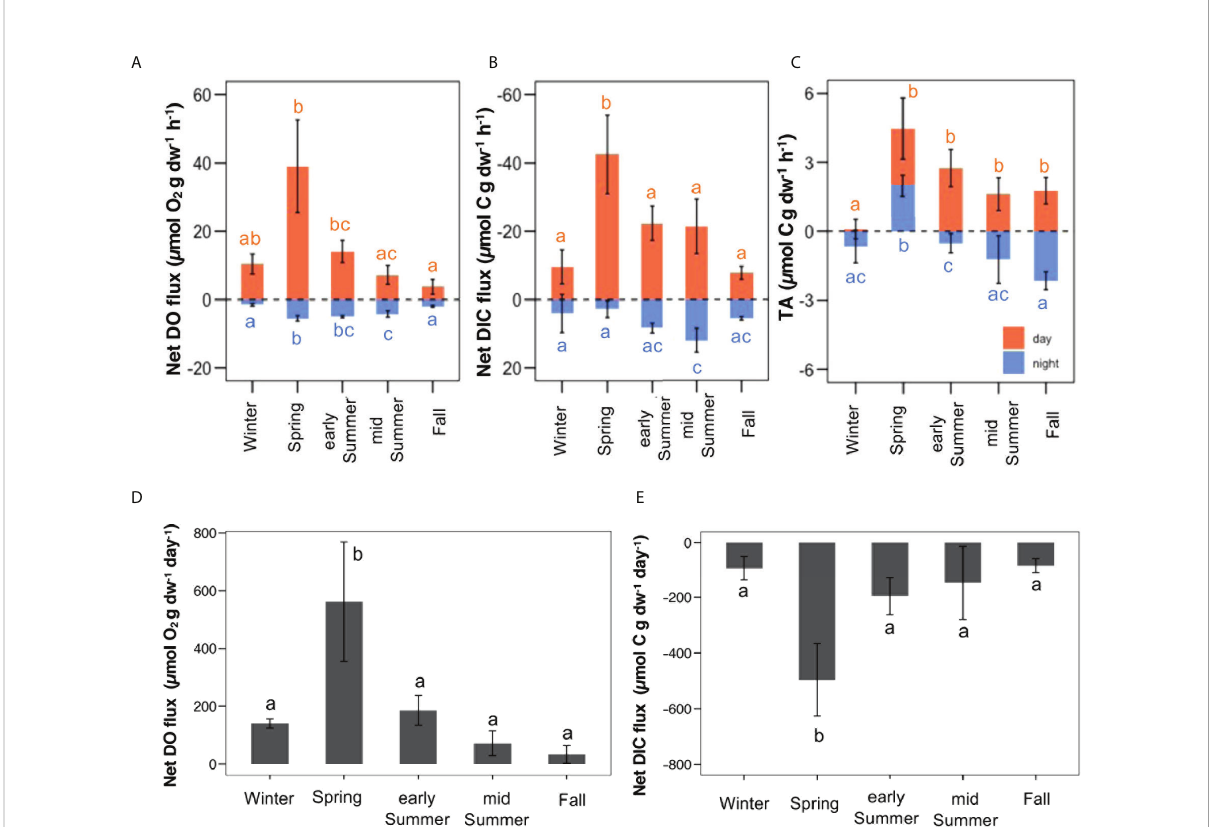
FIGURE 3 Seasonal metabolic rates measured in laboratory daytime (orange bars) and nighttime (blue bars) incubations, and corresponding diel DO and DIC fl uxes calculated from the measured rates. (A) Measured net hourly rates of dissolved oxygen production (positive values indicate net photosynthesis and negative values indicate respiration); (B) Measured net hourly rates of dissolved inorganic carbon (DIC) production (negative values indicate net photosynthesis and positive values indicate respiration); (C) Measured net hourly rates of total alkalinity (TA) production; (D) Calculated average diel rates of oxygen production; (E) Calculated average diel rates of DIC production. All the error bars represent standard deviation (± SD). Letters represent statistical differences between the